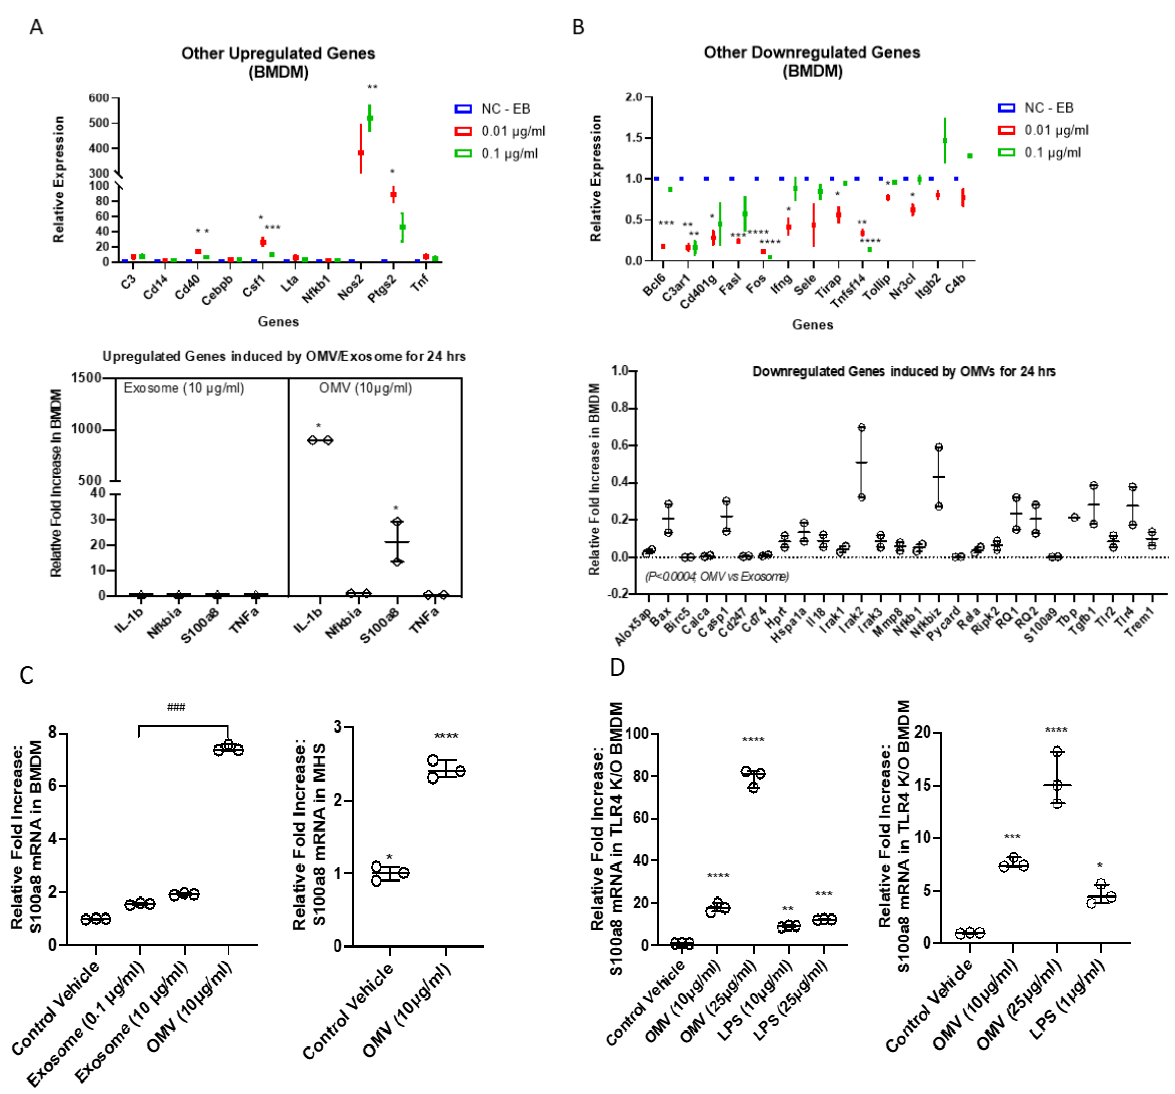
Figure 6. Expression profile of mouse inflammatory genes. ( A , B ) The top panel shows results from mouse inflammation and autoimmune array of BMDM treated with the indicated amounts of OMVs for 24 h. In the bottom panel, the profile of mRNA expression of inflammatory target genes was analyzed by M96 PrimePCR array plates utilizing the OMV or exosome-treated samples and plotted against those of their controls. Mouse BMDM were treated with 10 µg/mL OMV or EXO for 24 h. ( A ) A summary of the upregulated genes. ( B ) A summary of the downregulated genes. ( C , D ) The validated mRNA expression of S100a8 in BMDM (C-left), MHS (C-right), and TLR4 K/O BMDM ( D ), after treatment with control vehicle, and the indicated concentration of exosome and OMV.